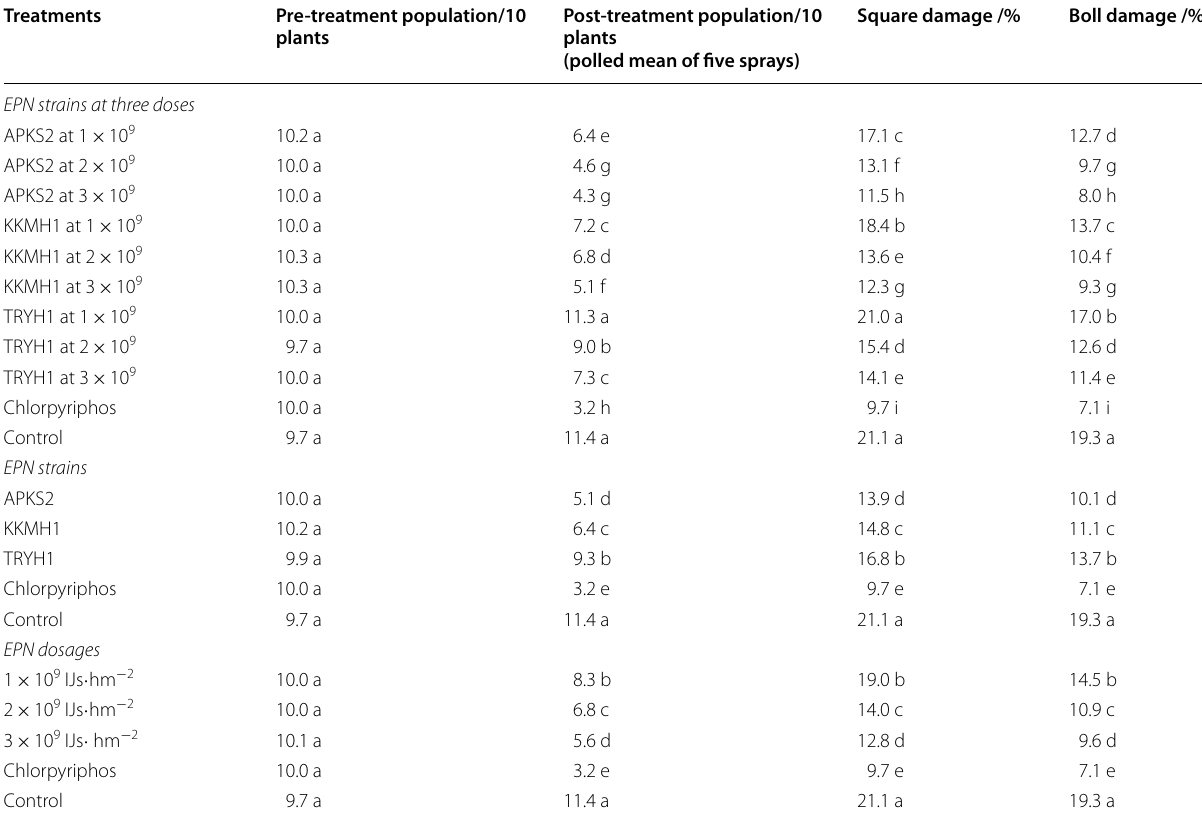
Table 2 Effect of EPN strains at three application rates on Helicoverpa armigera population, square and boll damage of cotton—Field experiment